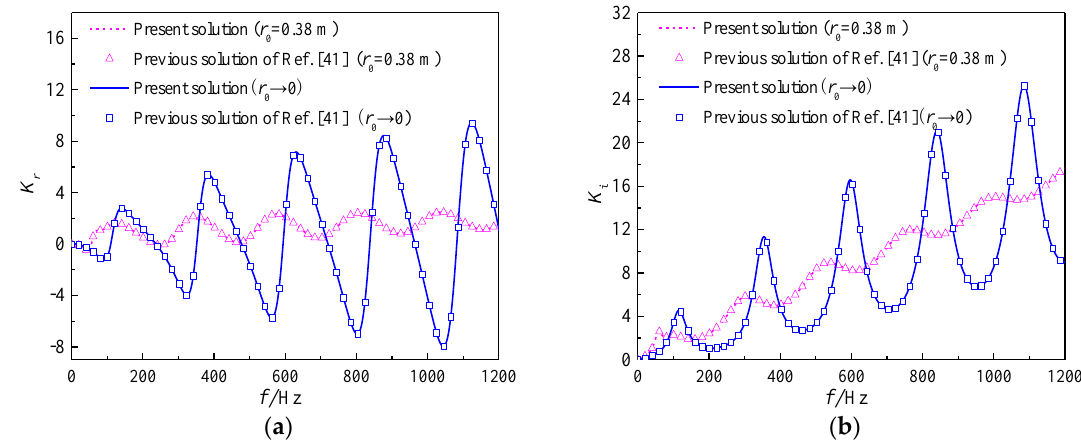
Figure 2. Contrast of the degradation of the present solution ( v p = 0, ζ s = 1 ) with the solution of Ref. [41]: ( a ) true stiffness and ( b ) equivalent damping.